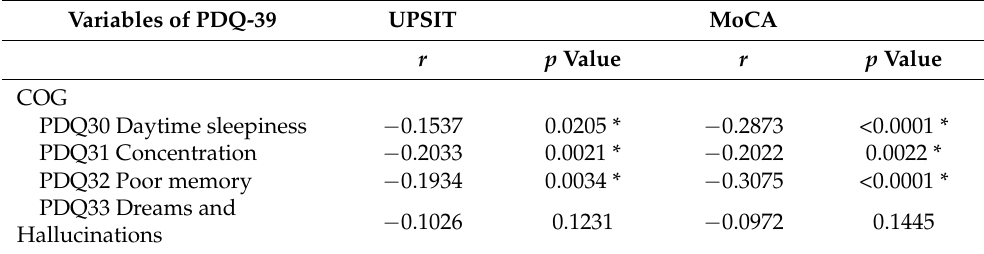
Table 7. Correlation between PDQ-39 COG dimension with UPSIT and MoCA, n = 227. Variables of